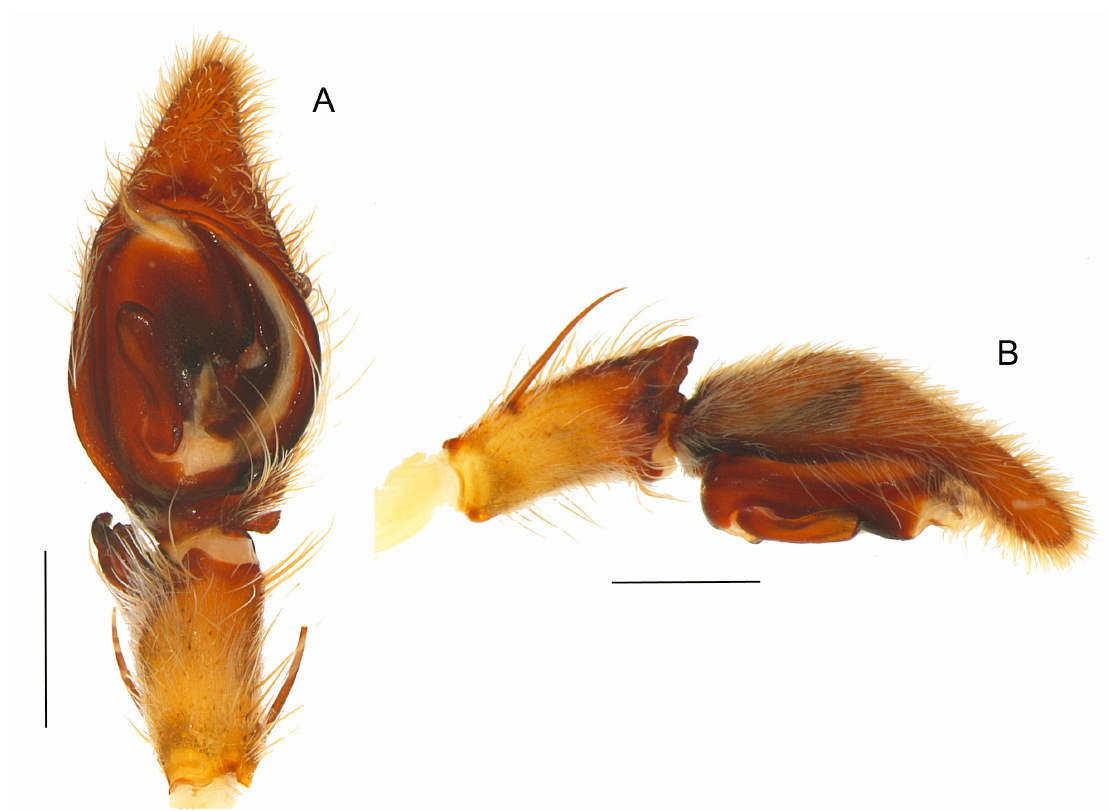
Fig. 14. Afroneutria immortalis (Arts, 1912) comb. nov. Male palp. A . Ventral view. B . Retrolateral view. Scale bars = 1 mm.